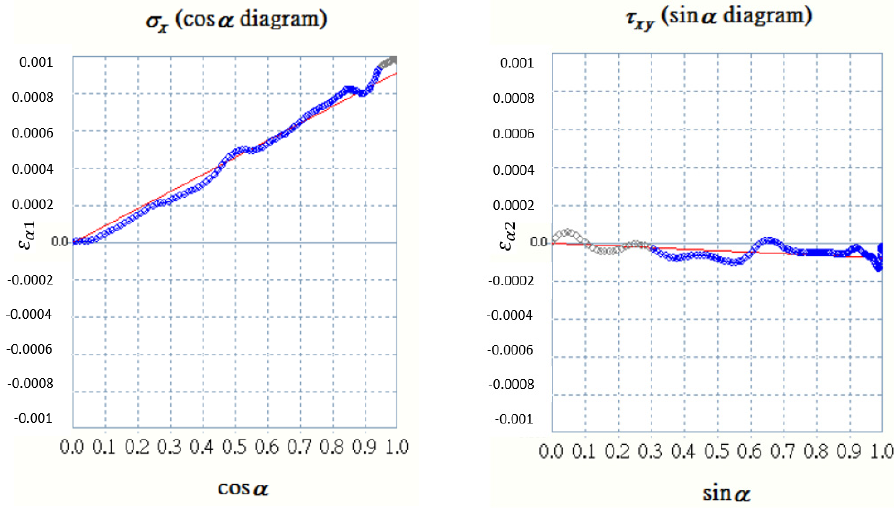
Figure 12. Variations of 𝜀 (cid:3080)(cid:2869) and 𝜀 (cid:3080)(cid:2870) with respect to cos 𝛼 and sin 𝛼 for a laser power of 500 W.